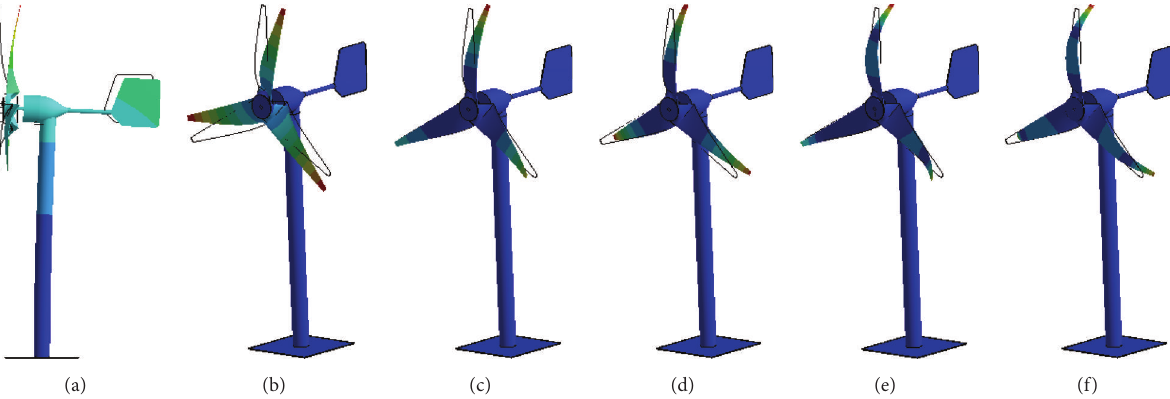
Figure 13: Determined vibration modes: (a) axial movement, (b) roundabout swing, (c) first-order antisymmetric vibration, (d) first-order symmetric vibration, (e) second-order antisymmetric vibration, and (f) second-order symmetric vibration.